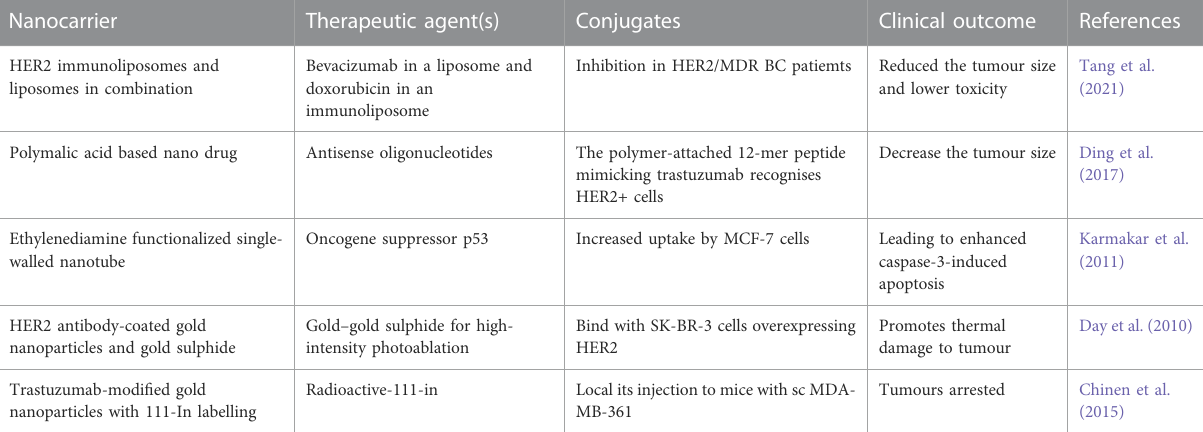
TABLE 5 The use of anti-HER2 ligand in various nano formulations to target HER2